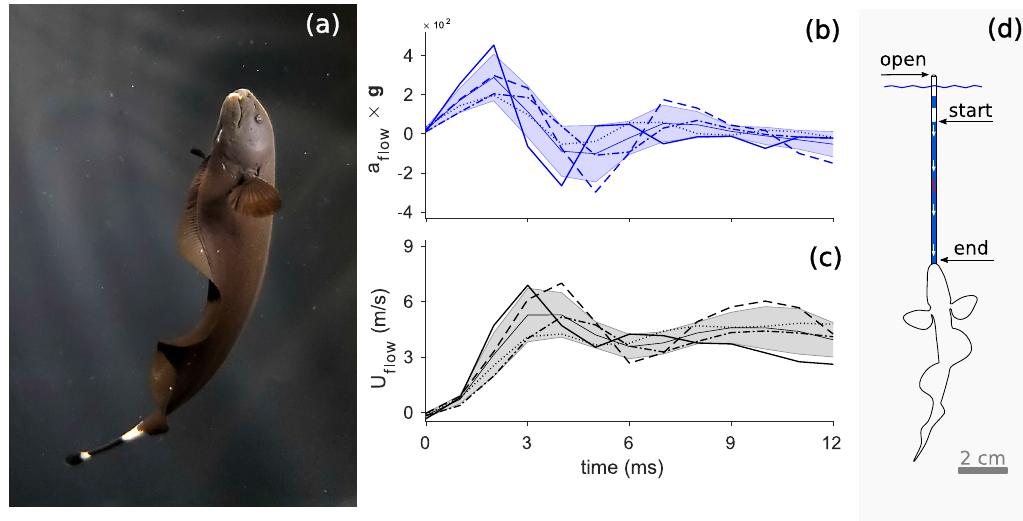
Figure 1. ( a ) Black ghost Knifefish ( Apteronotus albifrons ). ( b ) Flow acceleration (blue) and ( c ) speed (black) over time produced by suction in a capillary tube open to the air. Lines represent time series of each sampled individual. Starting time is when acceleration increases from zero. Shadows represent average value and one SD (N = 4). ( d ) Drawing represents the experimental setup. This figure was created using MATLAB R2017b (https :// www.mathw orks.com/), GIMP 2.8 (free available at: https ://www.gimp.org/), and Inkscape 0.92.3 (free available at: https ://inksc ape.org/).